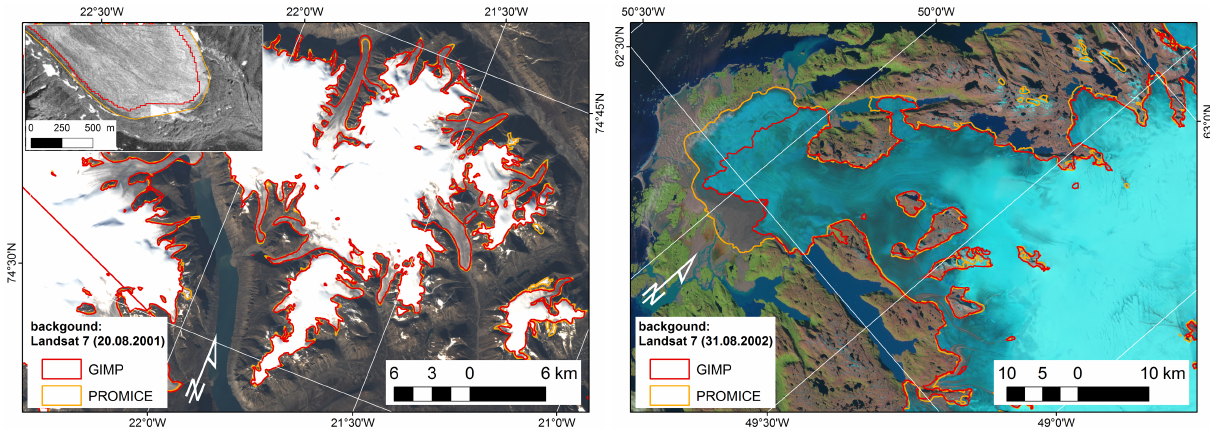
Fig. 3. (A) Overlay of the PROMICE and GIMP datasets showing advancing and retreating glacier termini at the A. P. Olsen ice cap (NE Greenland) between 1987 and ca. year 2000. The inset shows a detail view of a glacier terminus with the PROMICE and GIMP glacier outlines overlaid to the orthorectified aerial photograph from 1987. GIMP omits some smaller polygons included in the PROMICE dataset, and the partly frozen surface of the ice dammed lake is misclassified as glacier (visible to the east of the outlet glacier magnified in the inset); (B) comparison of PROMICE and GIMP ice margin polygons in the Frederiksh˚ab Isblink area exemplifies the difficulty of properly classifying debris-covered ice in GIMP ver. 1.2. A substantial ( > 70km 2 ) sector of the terminus where no debris-cover exists is also